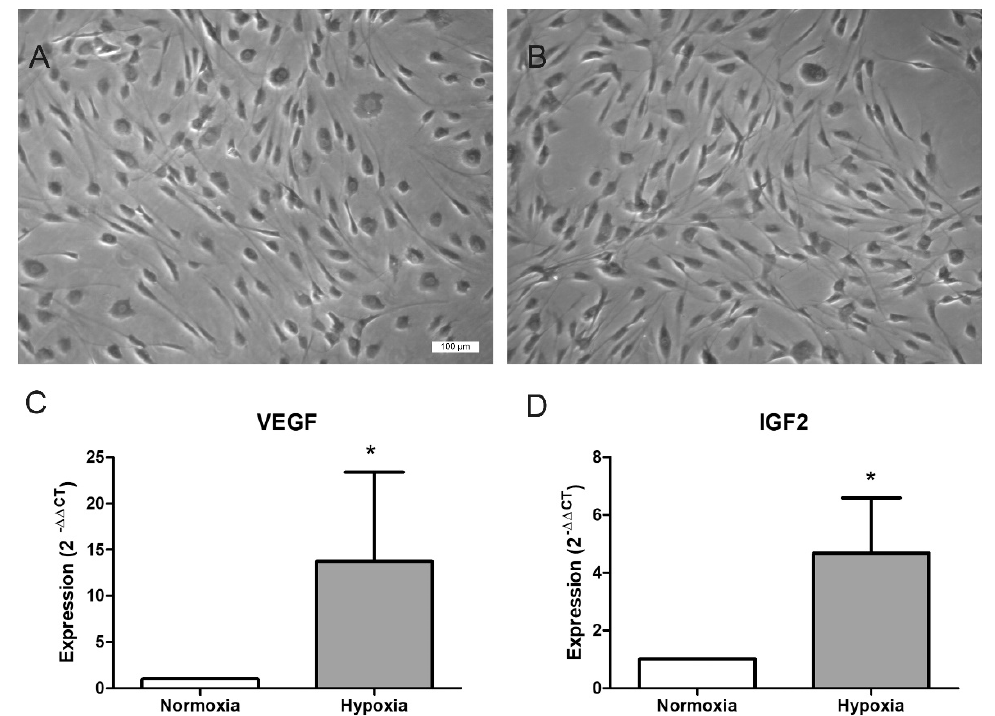
Figure 1. Characterization of adipose-derived mesenchymal stromal/stem cells (ASCs) in normoxia and hypoxia. ( A , B ) Cell morphology after culture in a normoxic ( A ) or a hypoxic environment (1% O 2 ) ( B ) after 48 h (phase contrast microscopy, scale bar = 100 µ m). ( C , D ) Effect of hypoxia on mRNA expression of vascular endothelial growth factor (VEGF) and insulin-like growth factor 2 (IGF2). Expression was quantified by qPCR analysis, normalized to β -actin, and calculated relative to the control using the ∆∆ CT method (mean ± SD; n = 5, * p < 0.05).